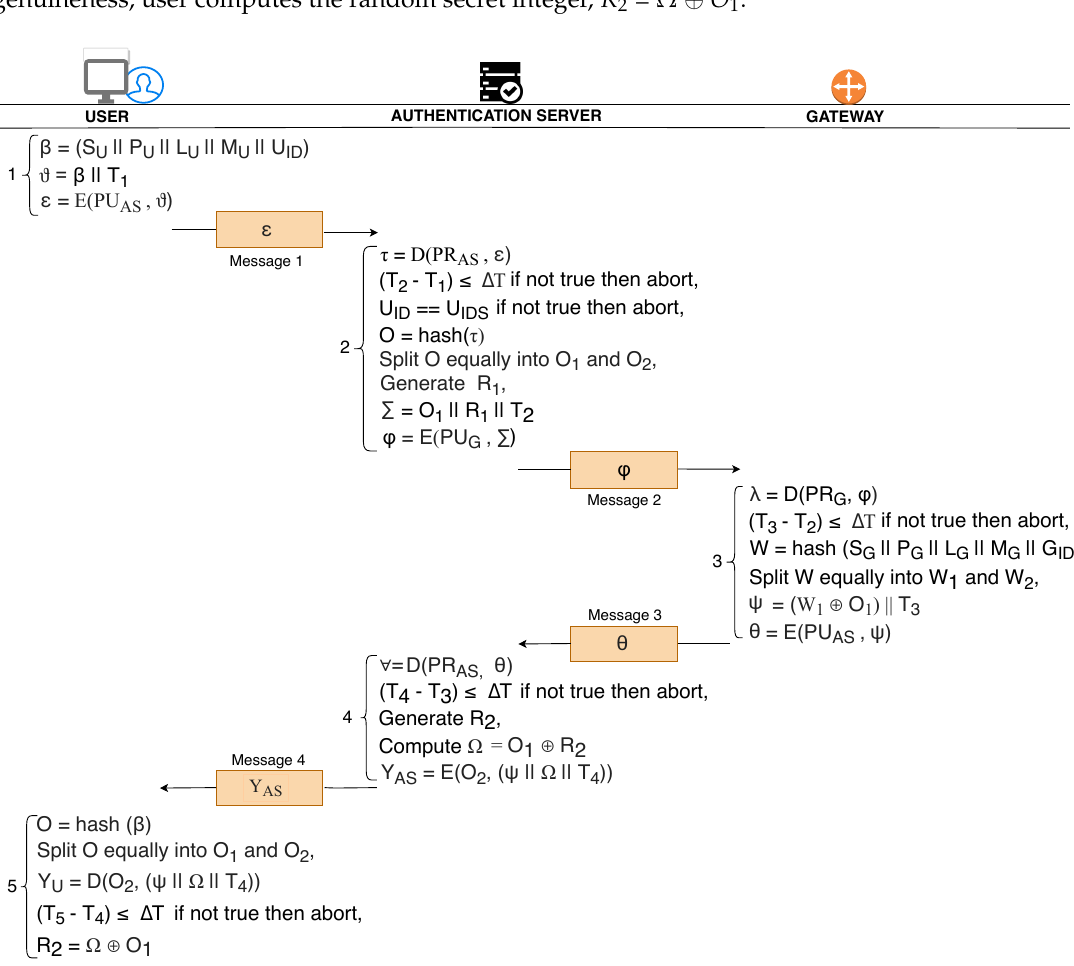
Figure 4. User device registration phase in MAKE-IT